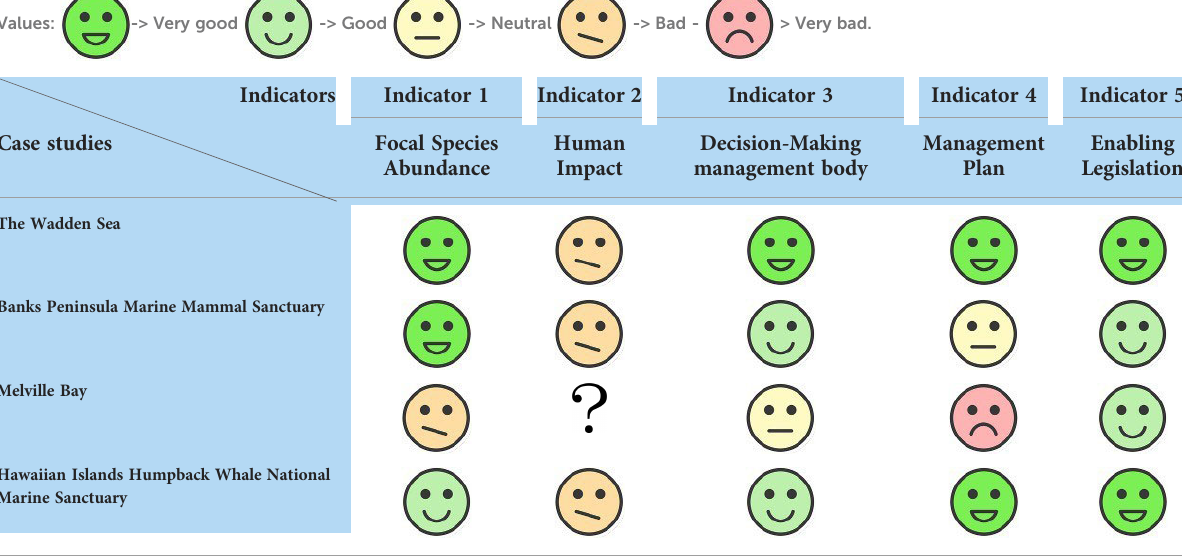
TABLE 3 Assessment of the indicators values for each case study, categorization based on the evaluation undertaken in